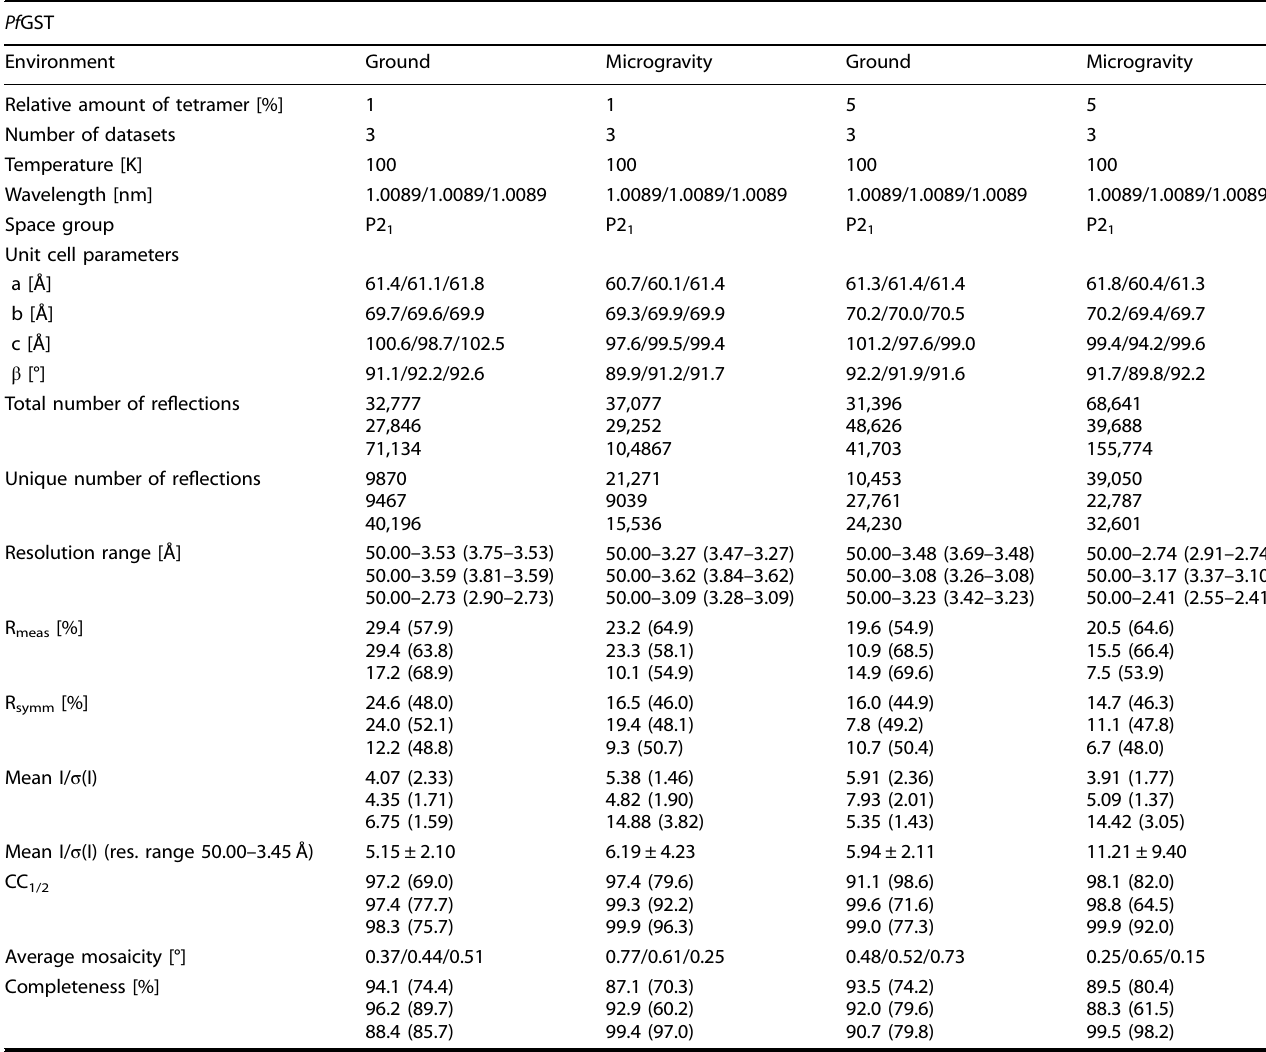
Table 2. Comparative summary and statistics of Pf GST X-ray diffraction data using 1 and 5% fl uorescence labeled tetramer applied as impurity during the crystallization experiments